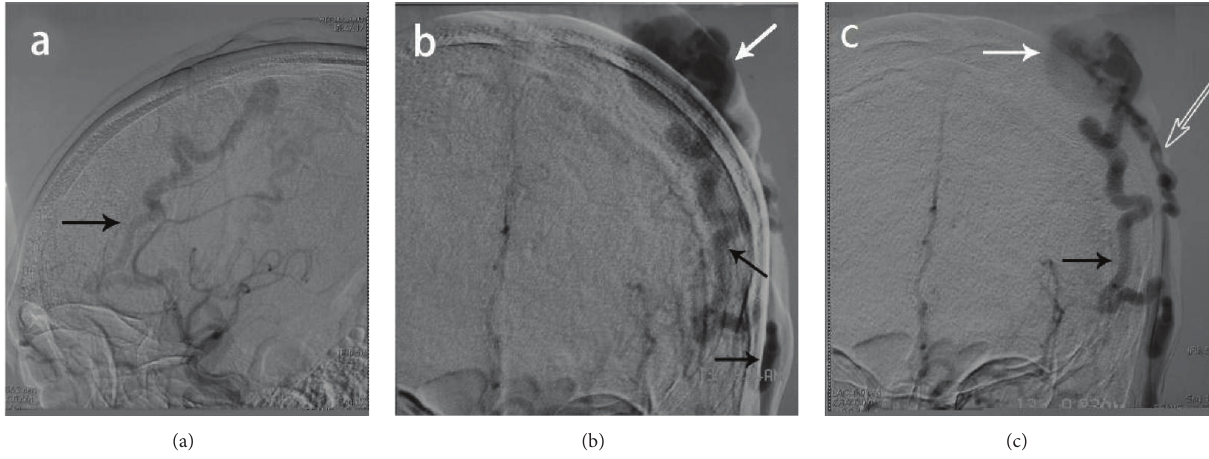
Figure 2: Digital subtraction angiography of the left ECA. (a) Lateral projection, early imaging, black arrow shows the left tortuous STA. (b) Anterior-posterior projection, black arrow shows the left STA which is thickened and tortuous supplies of blood, and the vascular mass is huge; the white arrow shows the point of the fistula. (c) Delayed imaging, black arrow shows the tortuous left STA, white arrow shows the vascular mass, and the hollow arrow shows the left subcutaneous drainage vein. ECA: external carotid artery; STA: superficial temporal